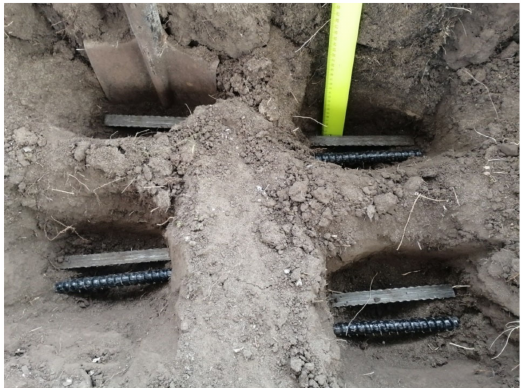
Figure 6. Picture of the field experiment configuration on the effect of destructive microorganisms on the process of biodamage of BFRP rebar test